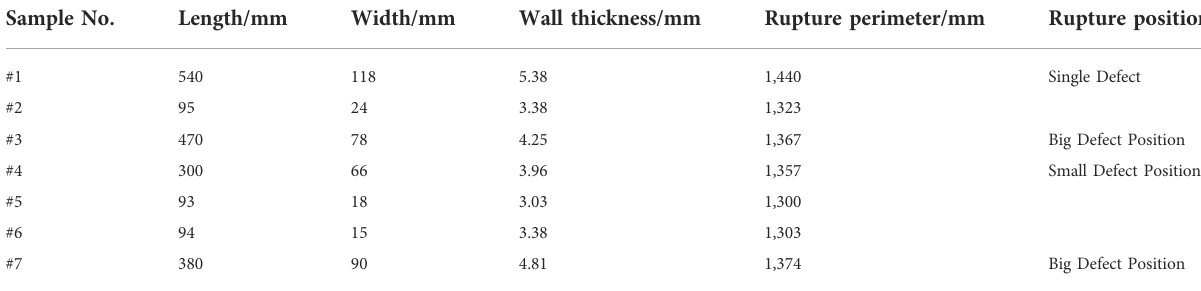
TABLE 5 The rupture size and positions of all